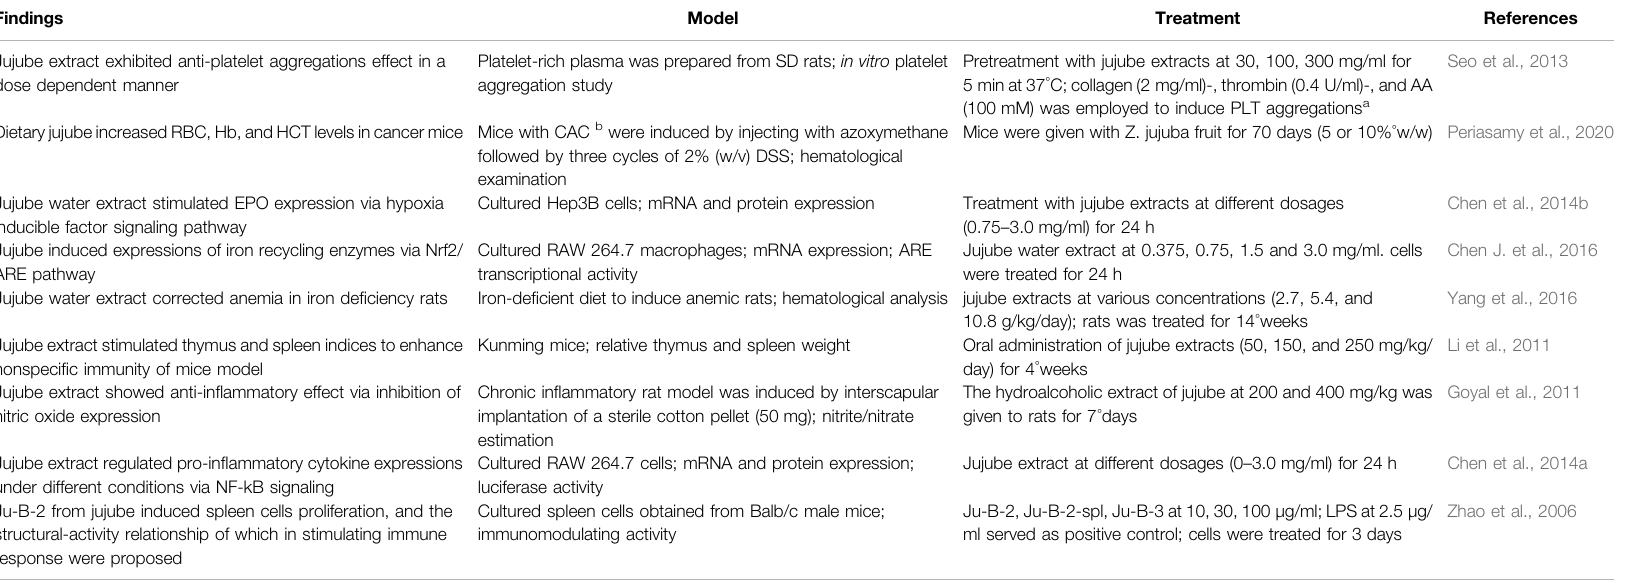
TABLE 2 | Hematopoietic properties of